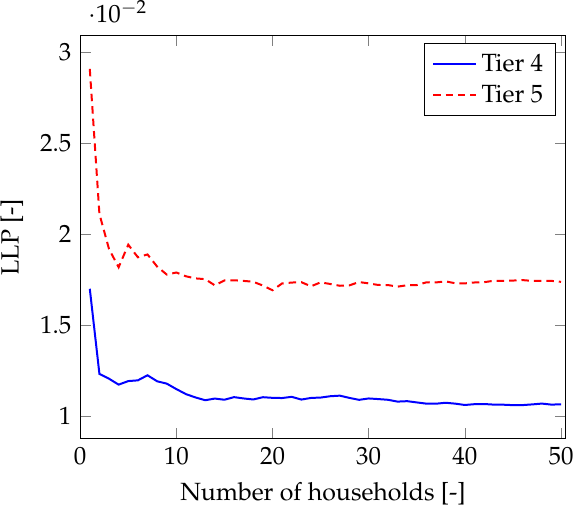
Figure 12. Impact of increasing microgrid size on LLP per household for homogeneous microgrids of tiers 4 and